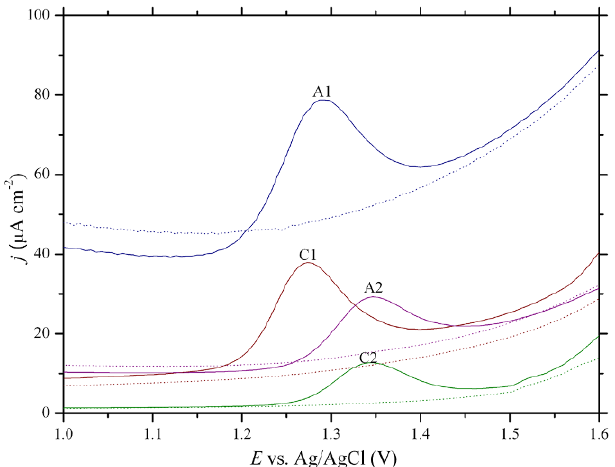
Figure 3. DP voltammograms of linuron (0.036 μmol cm -3 ) recording applying GCB (A) and GC-Metrohm (C) electrodes before (curves marked with 1) and after (curves marked with 2) electrochemical pretreatment. The experimental conditions were the same as in Fig. 2.